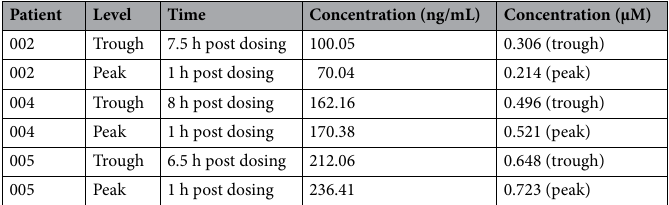
Table 3. PDMX1001/niclosamide trough and peak